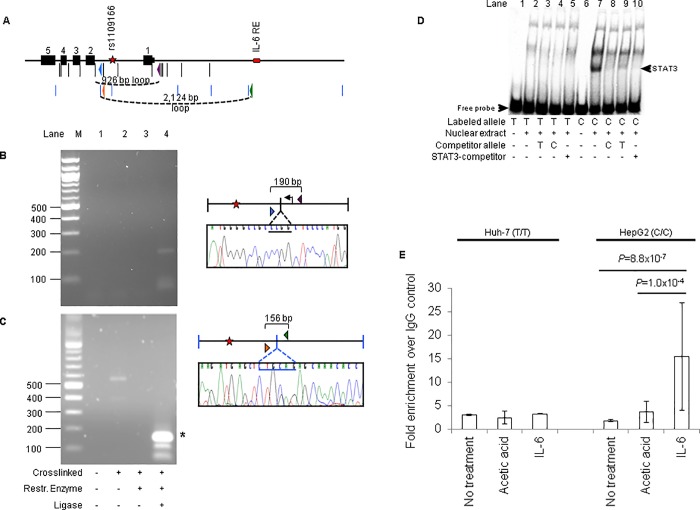
Chromatin interactions between rs1109166 and the LCAT promoter and an IL-6 response element.(A) The region containing the 5’ region and the first 5 exons of the LCAT. Black and blue vertical lines depict MspI and PstI sites respectively. A previously characterized IL6-responsive element [27] is indicated by a red bar. Other symbols are described in Fig 2. (B) 3C interaction between the SNP-promoter fragments. (C) 3C interaction between the SNP SNP and IL-6- responsive element. Distal interactions were only detected in cross-linked chromatin, in the presence of ligase, and were confirmed by Sanger sequencing. (D) STAT3 competitor oligos compete away a rs1109166-C-specific band in EMSA (lane 10). (E) Chromatin immunoprecipitation shows enhanced STAT3-binding to rs1109166-C allele after cells are treated with IL-6.